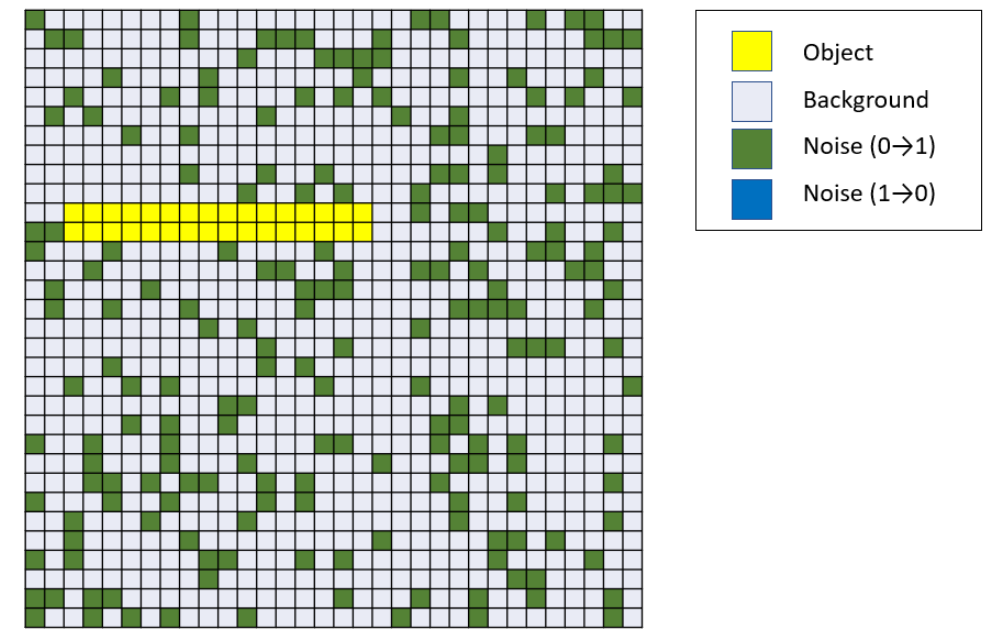
Figure 16. A total of 30 pixel, 0° 20% background